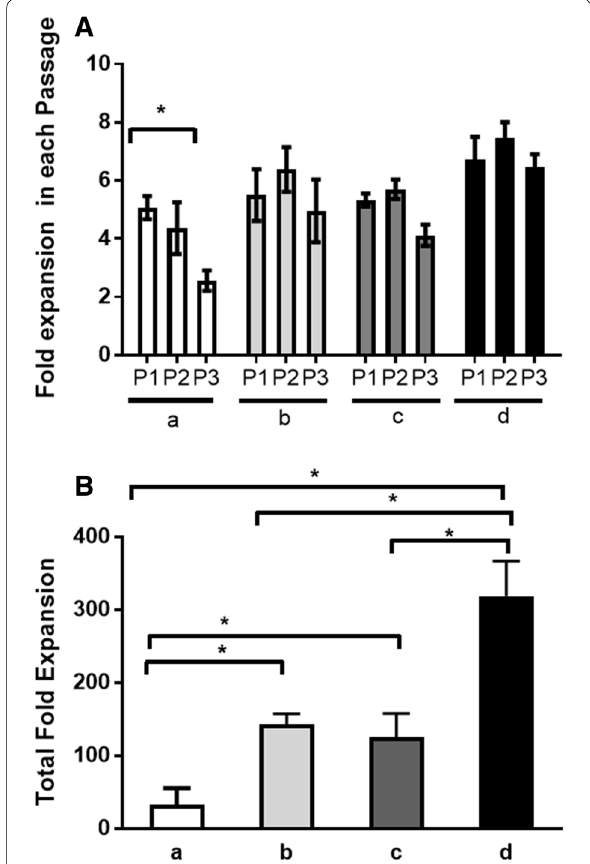
Fig. 4 Synergism of FGF/MEK/ERK signaling and Wnt/β‑catenin signaling in maintaining mESC proliferation. The concentration of SB216763, SU5402 and PD0325901 used here was 5 μM, 2 μM and 1 μM. A Comparison of fold expansion in each passage. B Fold expansion of total cells after three passages. Group a (no treatment), Group b (SB216763), Group c (PD0325901 SU5402), Group d + (PD0325901 SU5402 SB216763). Error bars are standard deviations + + ( n 3). *Represents significant difference ( P < =